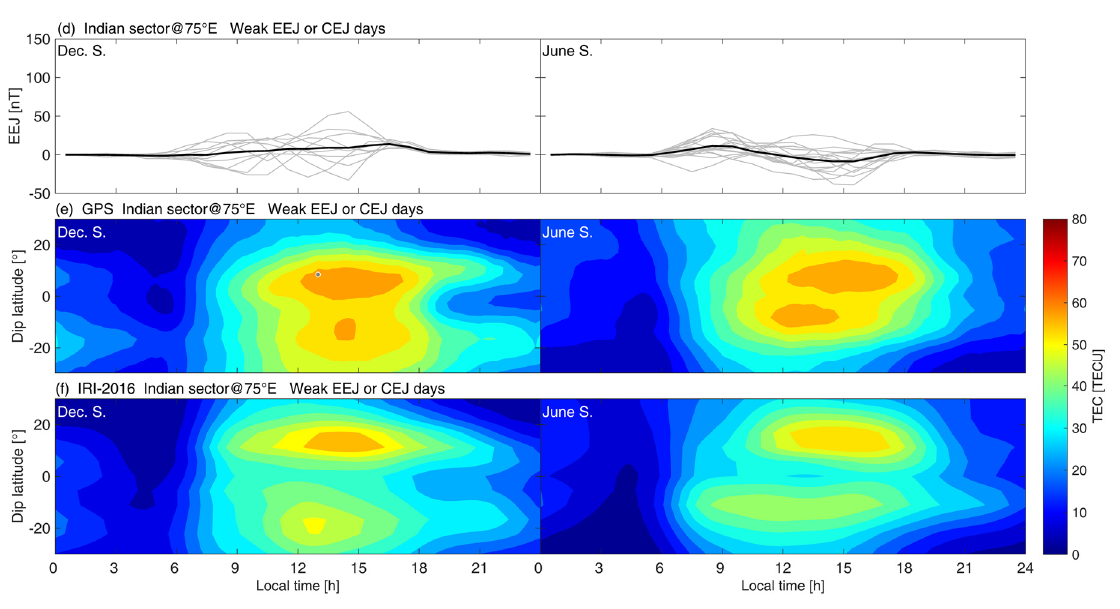
Figure 4. Similar to Figure 3, but during days that the average EEJ intensity at 0800–1200 UT was relatively low (refer to WEC days) at Peruvian sector ( a – c ) and Indian sector ( d – f ). The lack of equinox results in ( d – f ) is due to that the WEC days are not found.